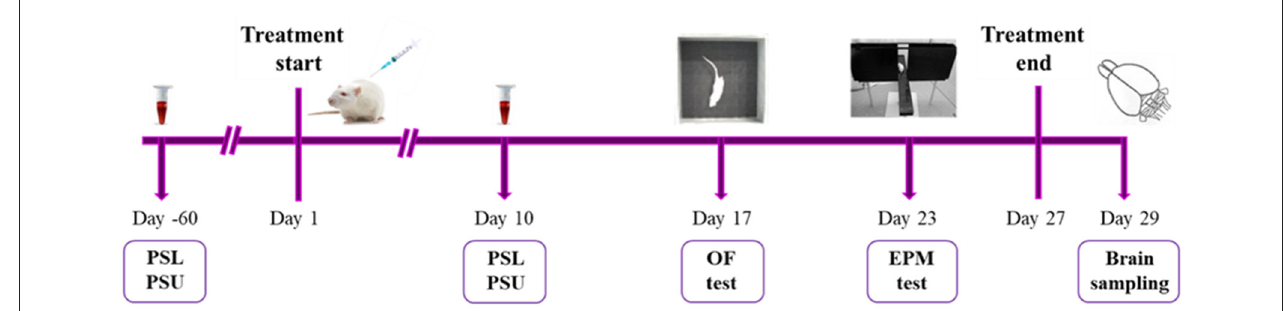
FIGURE 1 | A scheme illustrating experimental design and time course of analyses. At the age of 5–6 weeks (60 days before the start of the treatment), animals from high-5HT and low-5HT subline were subjected to blood sampling for verification of platelet serotonin level (PSL) and platelet serotonin uptake (PSU). At the age of 13–14 weeks, rats from both sublines were randomly divided into two groups and for the following 27 days were daily treated with i.p. injections of either vehicle ( n = 8 per subline) or fluoxetine (6 mg/kg; n = 17 per subline). On day 10 of treatment, all animals receiving vehicle and subset of animals receiving fluoxetine ( n = 8 per subline) were subjected to blood sampling for PSL and PSU measurements. On days 17 and 23 of treatment, all animals underwent behavioral assessment in open field (OF) and elevated plus maze (EPM) test, respectively. 48h after the last (27th) injection of vehicle or fluoxetine, animals were sacrificed, and cortical brain tissue samples were taken for 5HT level measurements and gene expression